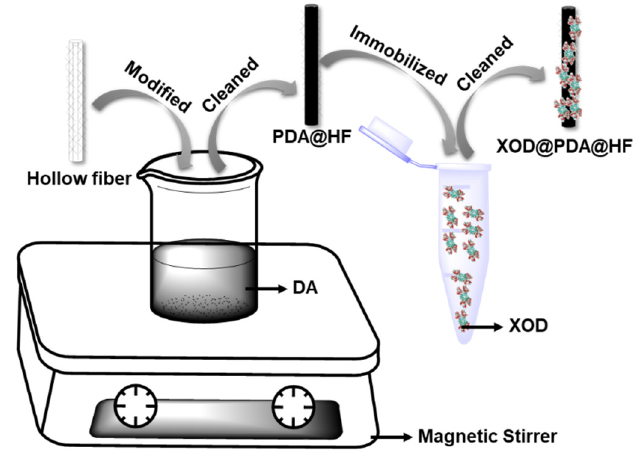
Figure 8. Schematic diagram of PDA-modified hollow fiber-immobilized XOD.